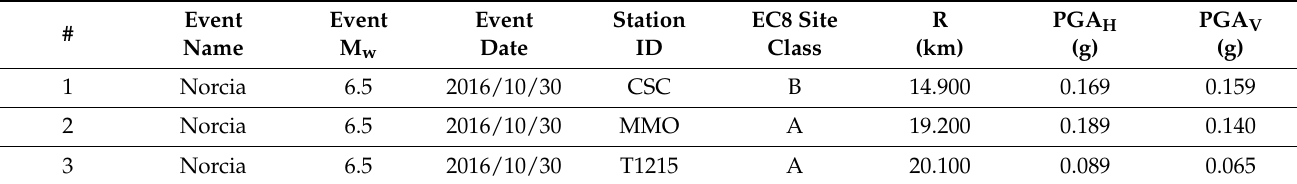
Table 4. Ground motion